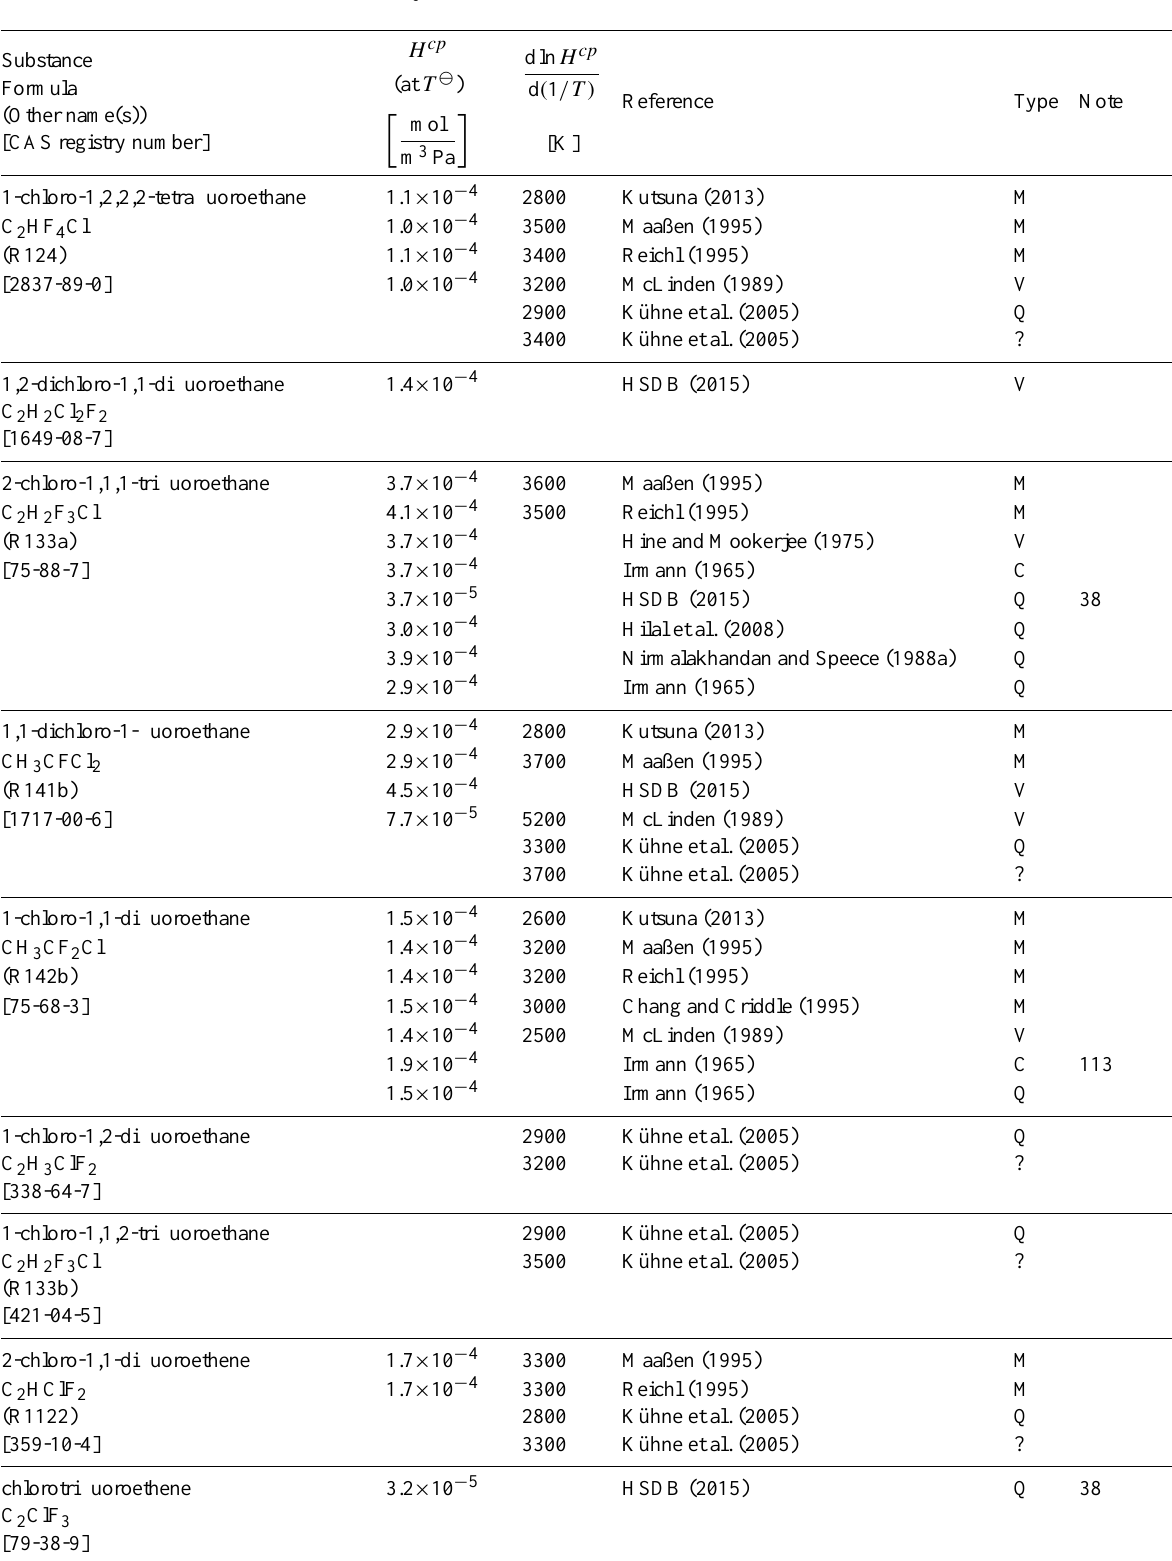
Table 6: Henry’s law constants for water as solvent